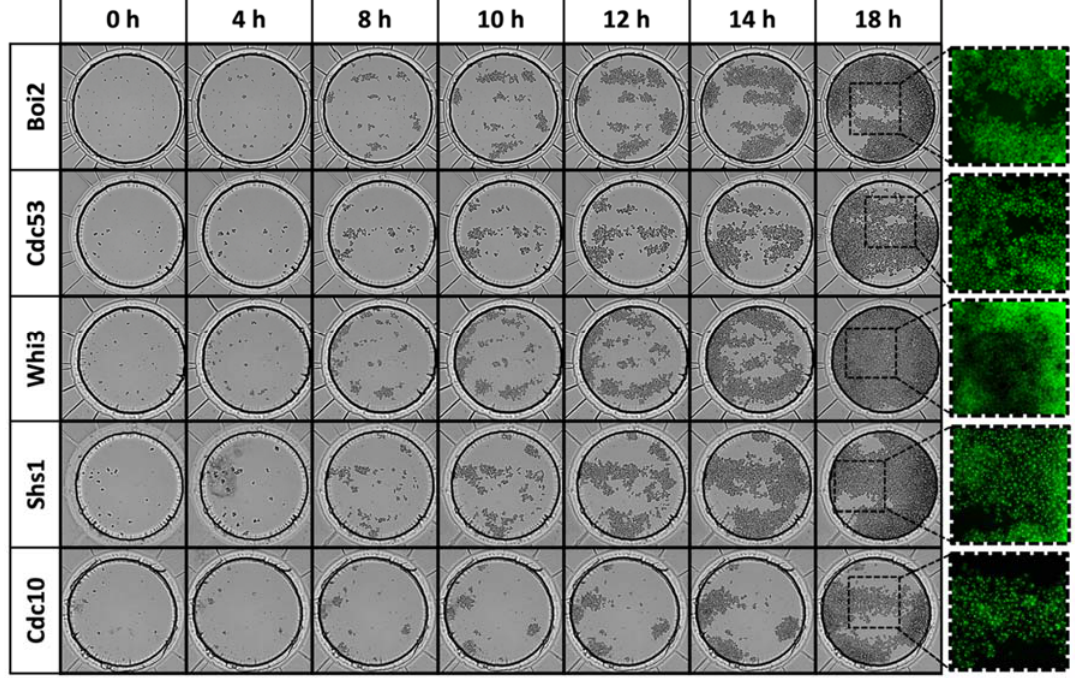
Figure 5. Evaluation of the washing protocol to avoid cross ‐ contamination. (a) Printing pattern to evaluate the washing protocol of the piezo dispenser. Transparent wells contain a yeast solution in PBS, and the colored wells contain a blue dye (no cells). (b) Washing protocol based on pressure resulted in 1 cross ‐ contamination colony. (c) Washing protocol based on the syringe pump resulted in spotting without cross ‐ contamination.